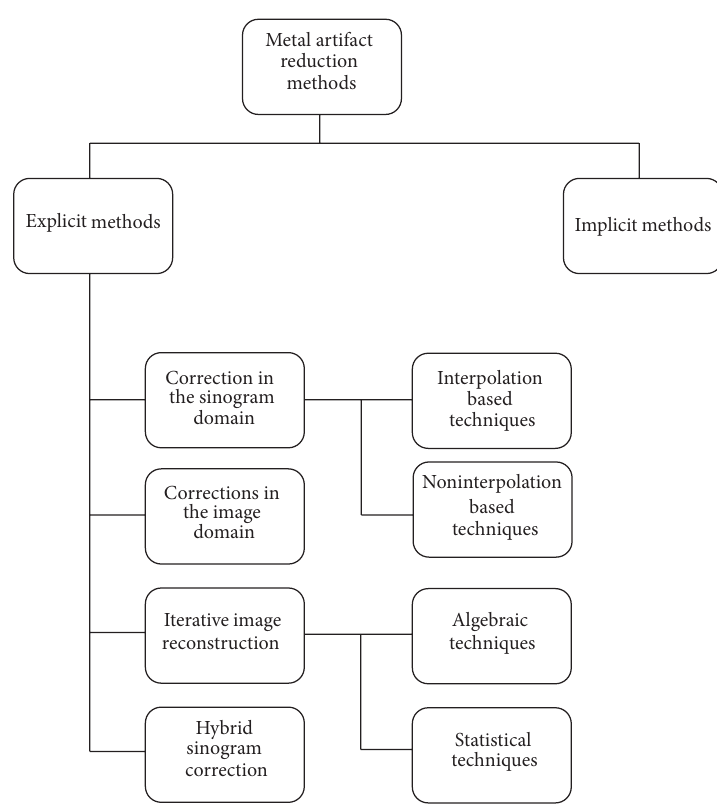
Figure 1: Classification of metal artifact